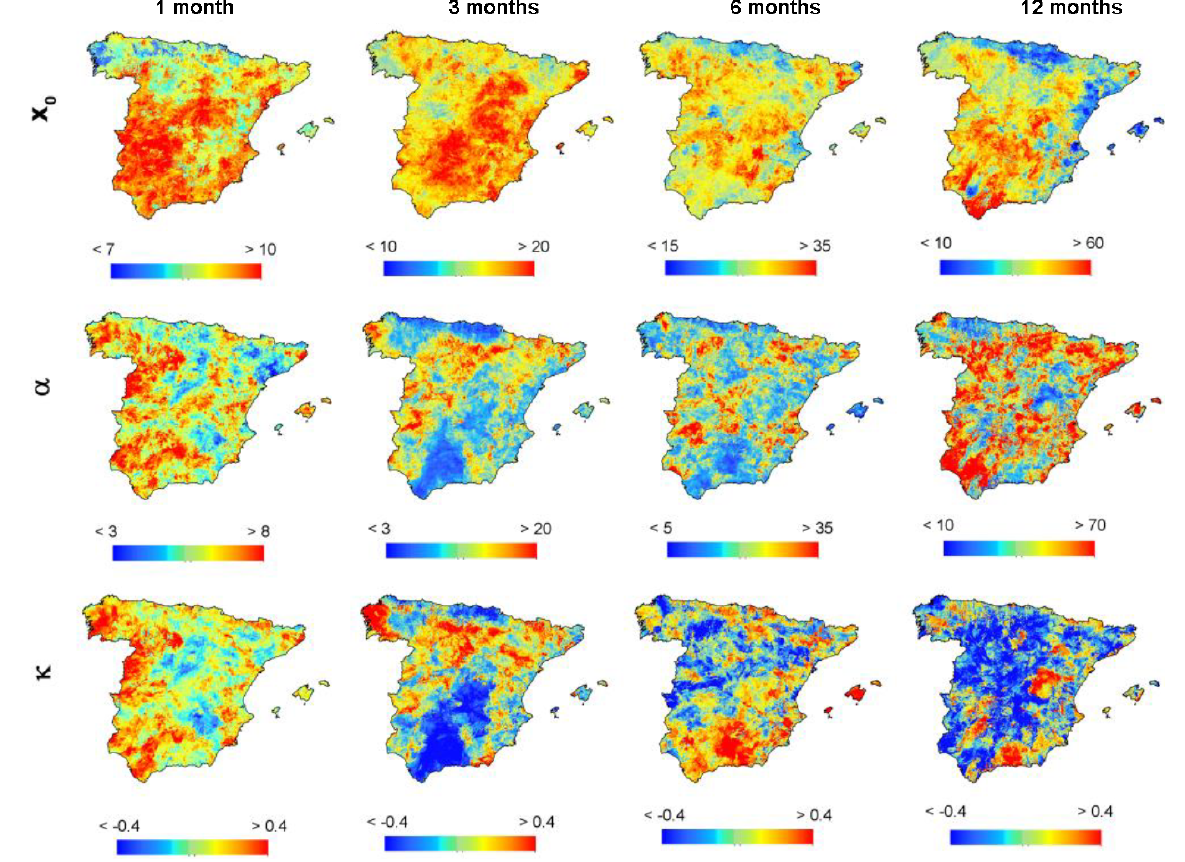
Figure 8. Spatial distribution of the parameters of the GP distribution calculated for the SPEI duration